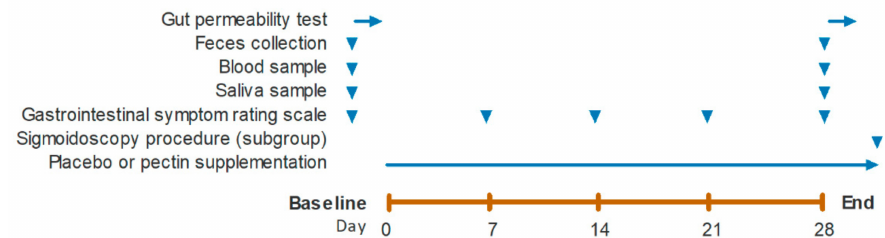
Figure 1. Timeline of the intervention period. Gut permeability test, feces collection, blood and saliva sampling, gastrointestinal symptom rating scale, sigmoidoscopy procedure, and placebo or pectin supplementation were completed at the days as indicated by arrows. Intake of supplements continued until all measurements were